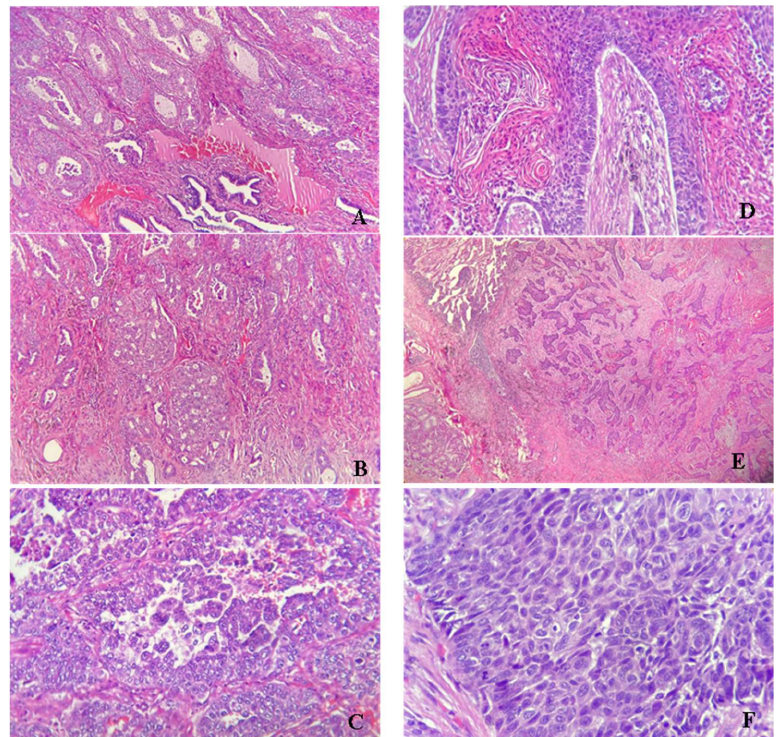
Figure 8. ( A ) Pulmonary adenocarcinoma moderate defined, bronchial origin (HE × 100); ( B ) Crib- riform pulmonary adenocarcinoma (HE × 100); ( C ) Poor differentiated pulmonary adenocarcinoma (HE × 400); ( D ) Keratinized squamous cell carcinoma (HE × 200); ( E ) Not differentiated squamous cell carcinoma (HE × 100); ( F ) Atypical mitoses in squamous cell carcinoma (HE × 400).